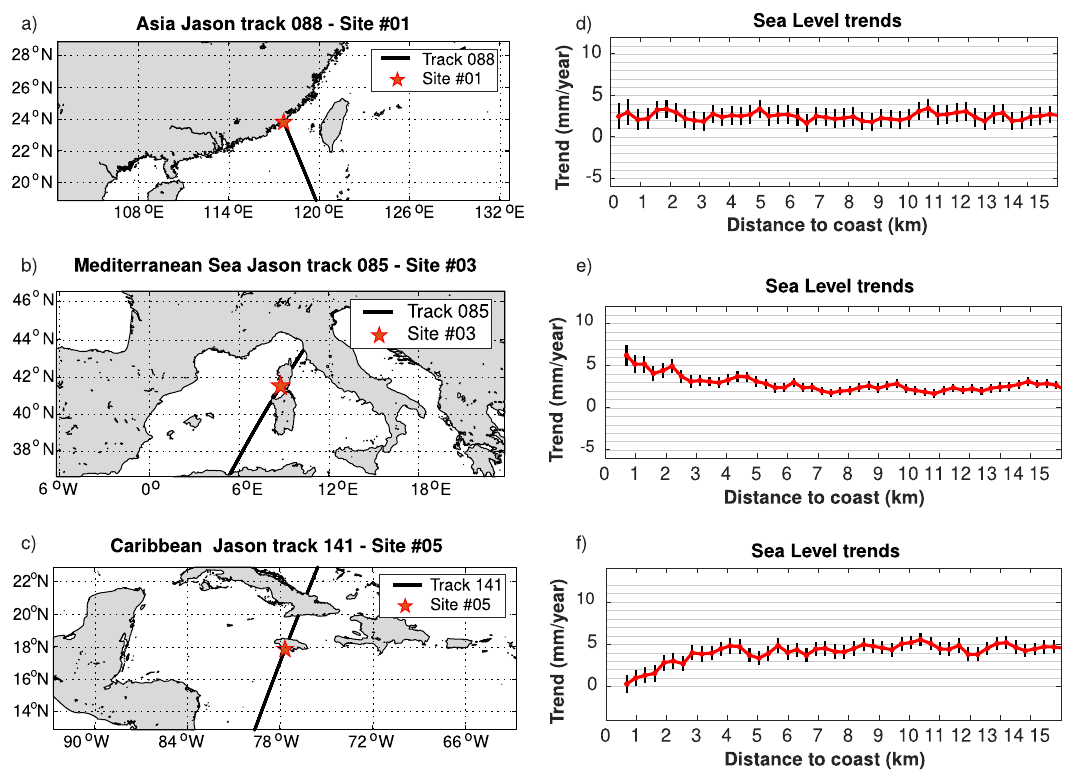
Fig. 4 Examples of along-track sea level trends and associated 1-sigma error against distance to the coast. a – c show coastal site location (red star) and associated Jason track (black line). d – f represent sea level trends against distance to the coast (red curve) and associated trend error (black vertical